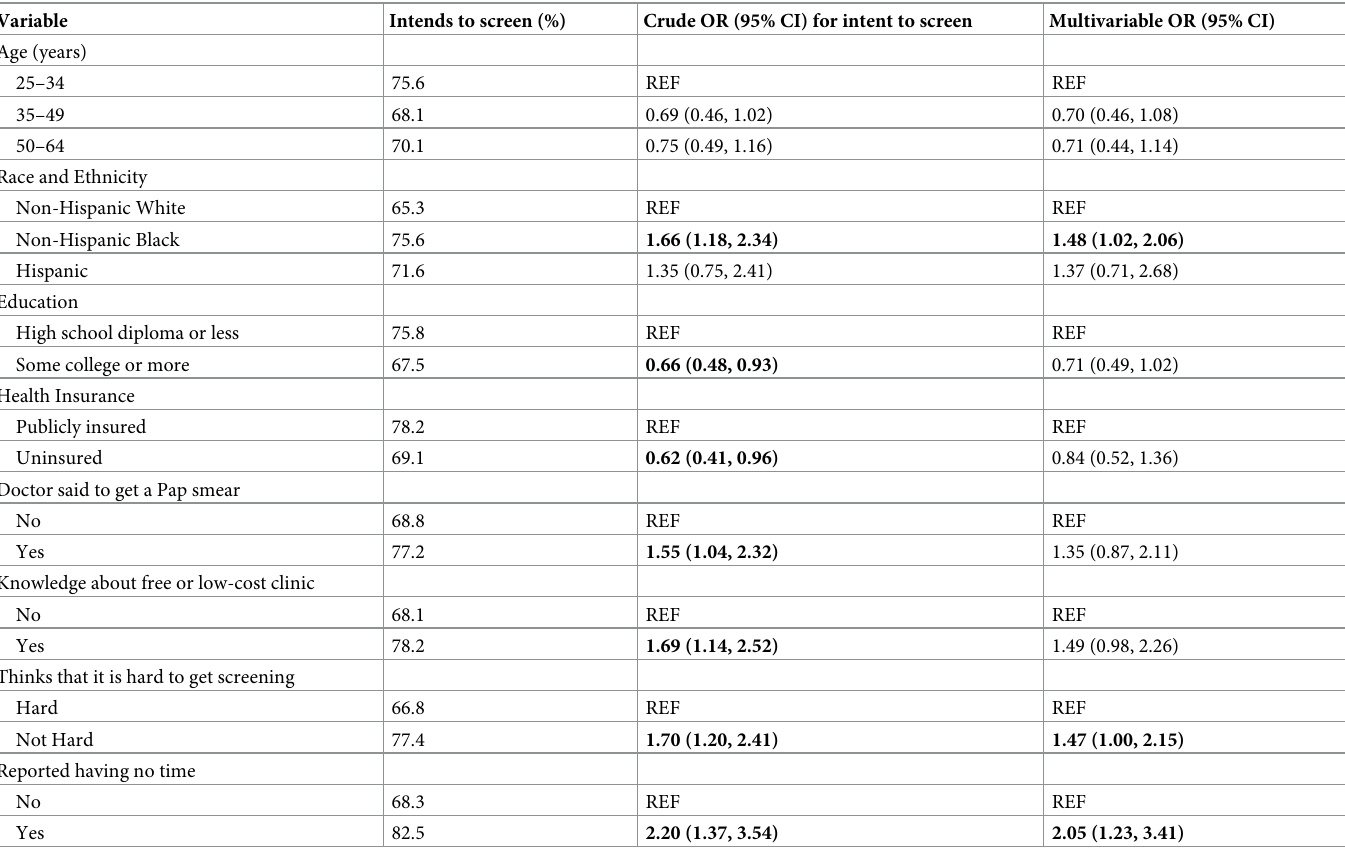
Table 3. Predictors of intention to